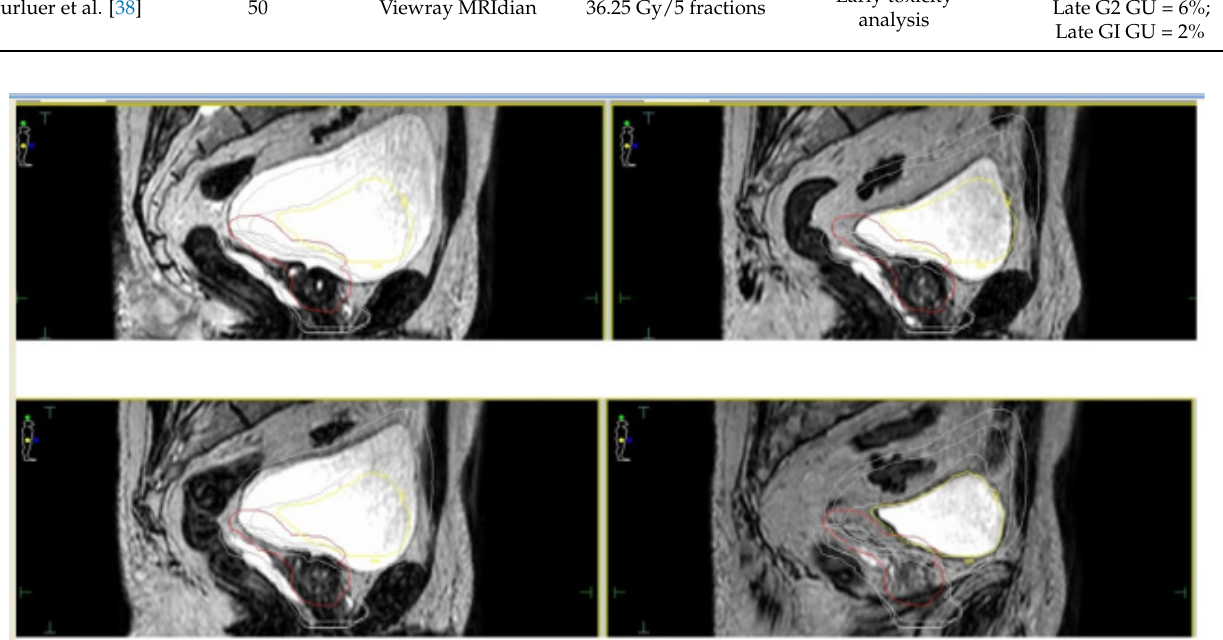
Figure 2. Daily interfraction variability of Planning Target Volume (PTV) and bladder. A T2-weighted gradient-echo sequence is acquired for a better visualization of the prostate gland. After the re-optimization of the plan, a further cine MR, usually acquired on sagittal and coronal planes, is performed to check organ motion during the beam-on time (Figure 3).